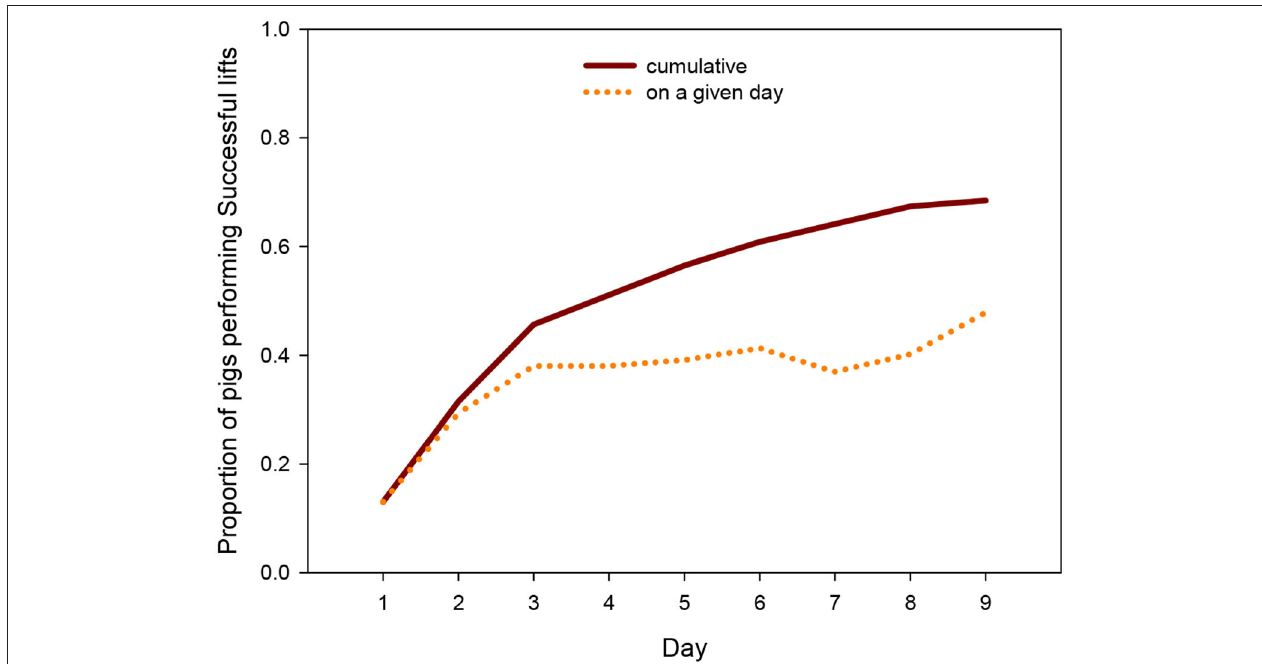
FIGURE 2 | Proportion of pigs per day and cumulative proportion that successfully lifted the log across